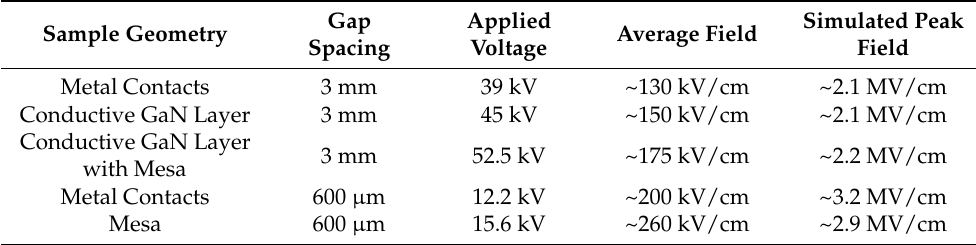
Table 1. Summary of testing results for all geometries and the simulated peak electric field at